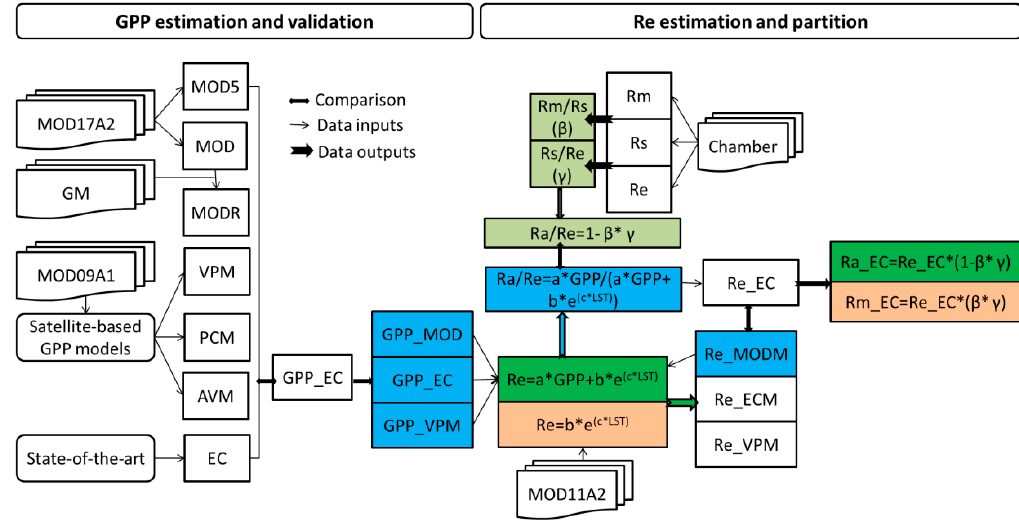
Figure 1. Conceptual graph for satellite-based estimation and partitioning of ecosystem respiration in an alpine meadow on the Tibetan Plateau. MOD17A2, MOD09A1, and MOD11A2 are the MODIS products. GPP is gross primary production. GM is short for ground measurements, including meteorological and vegetation measurements (Methods). MOD5, MOD and MODR are the MODIS version 5, version 6 GPP products from MOD17A2 and revised version 6 GPP products based on ground measurements. VPM, PCM, and AVM are different satellite-based GPP estimation models that are vegetation photosynthesis model, photosynthetic capacity model, and alpine vegetation model, respectively. EC is short for eddy covariance, which is the state-of-the-art method to measure CO 2 flux. Re, Rs, Rm and Ra are ecosystem respiration, soil respiration, heterotrophic respiration and autotrophic respiration, respectively. Re_MODM, Re_ECM, and Re_VPMM are the satellite-based Re estimations based on GPP_MOD, GPP_EC and GPP_VPM, respectively. Blue, green and orange boxes are the best satellite-based estimations of corresponding measurements based on multi-model comparison, Re estimations in growing season (or Ra_EC), and Re estimations in non-growing season (or Rm_EC), respectively.